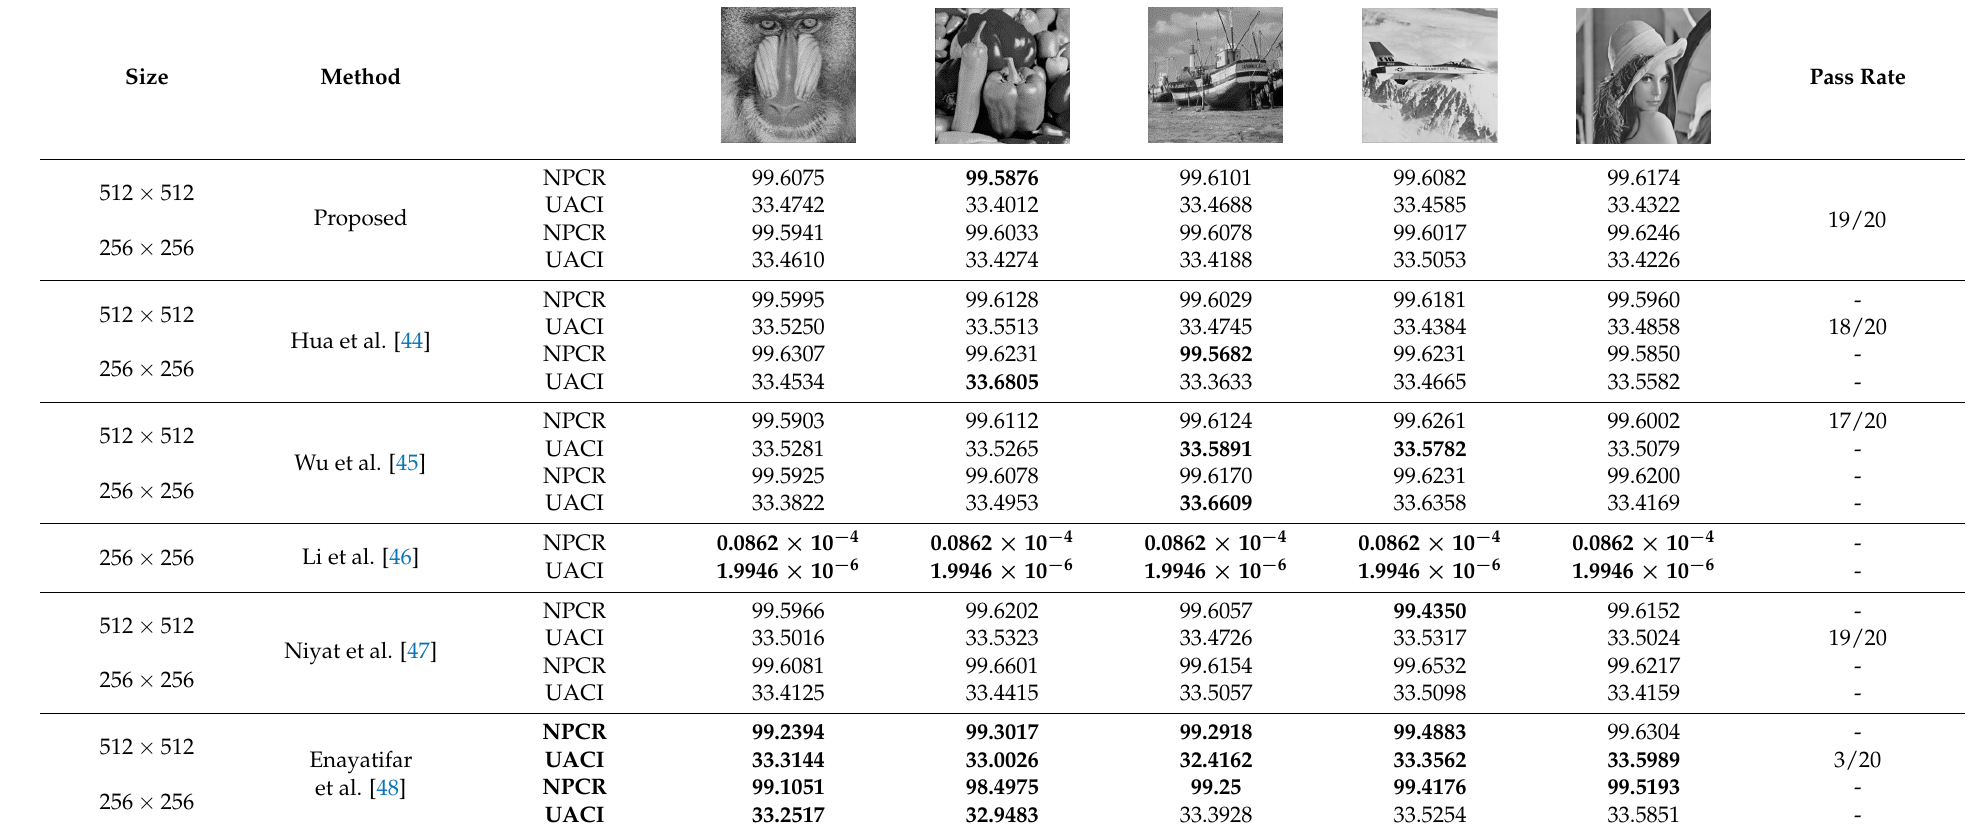
Table 6. Number of Pixels Change Rate (NPCR) and Unified Average Changing Intensity (UACI) of the encrypted image using different encryption algorithms.